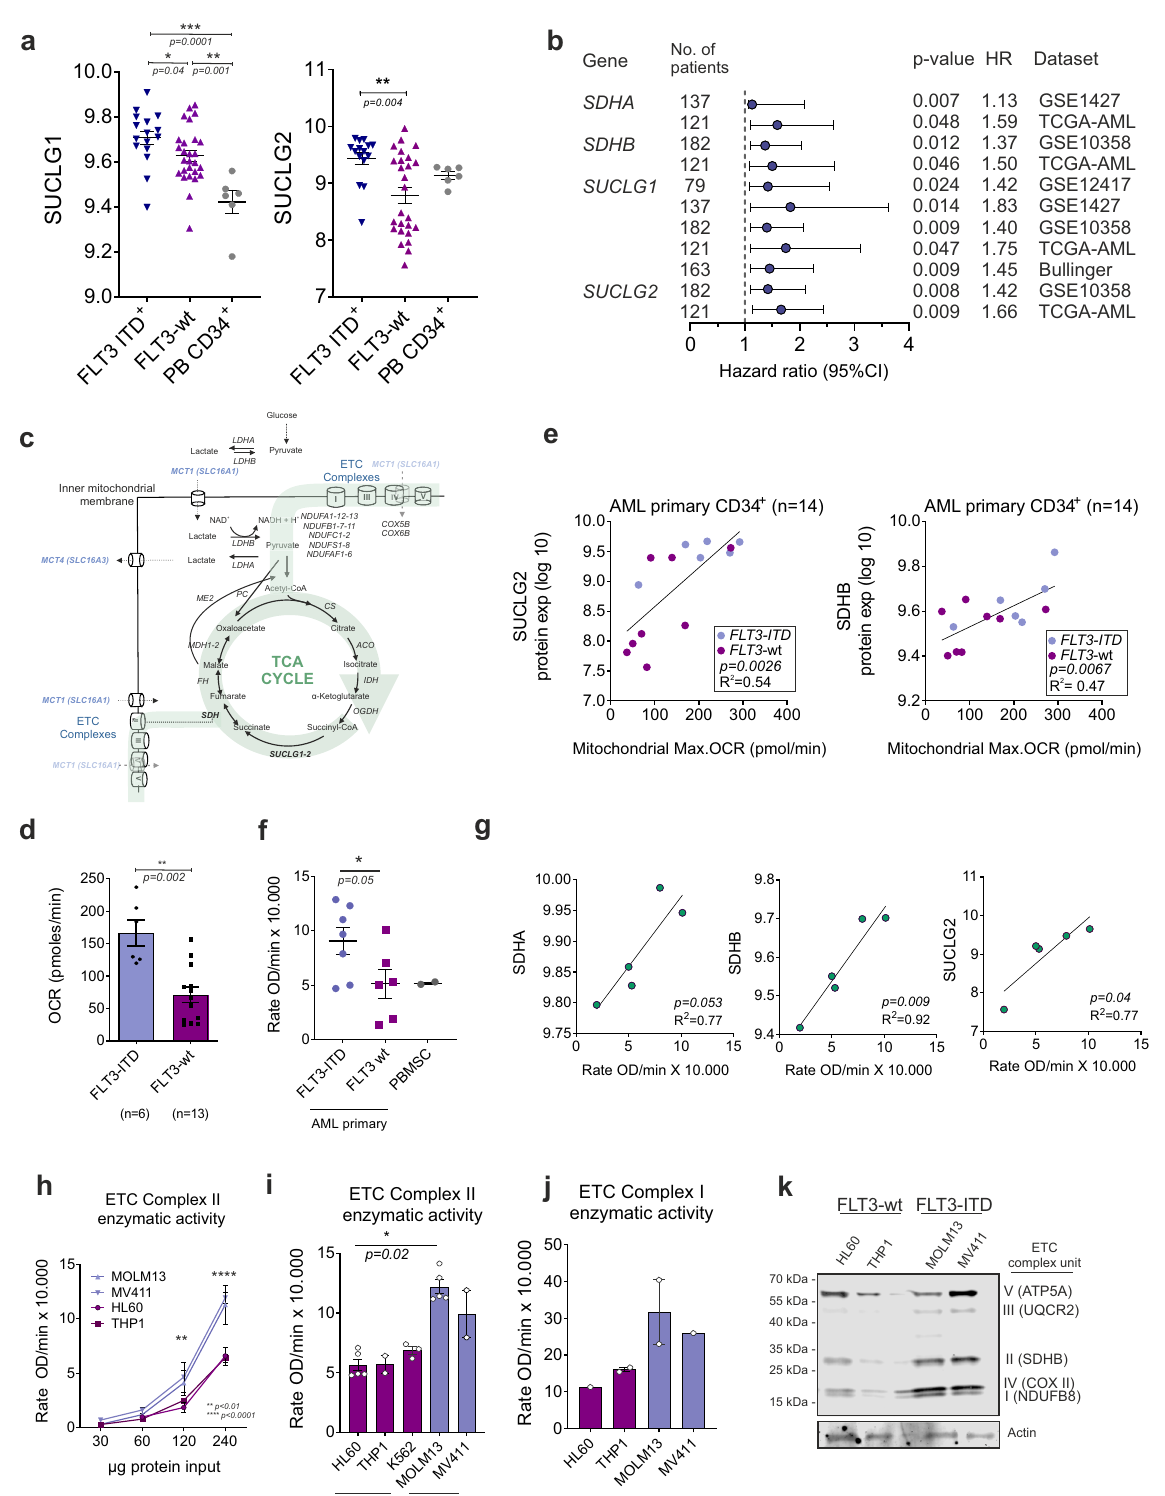
protein expression (Fig. 1g). The OXPHOS-driven cell lines MOLM13 and MV411 displayed higher ETC complex II activity compared to the FLT3 -wt glycolytic line HL60 and FLT3 -wt K562 cells (Fig. 1h, i). A similar trend was seen for ETC complex I activity, although this did not reach signi fi cance (Fig. 1j). Inter- estingly, the MLL-AF9-driven OXPHOS cell line THP1 displayed ETC complex I/II activity levels comparable to HL60 (Fig. 1h –